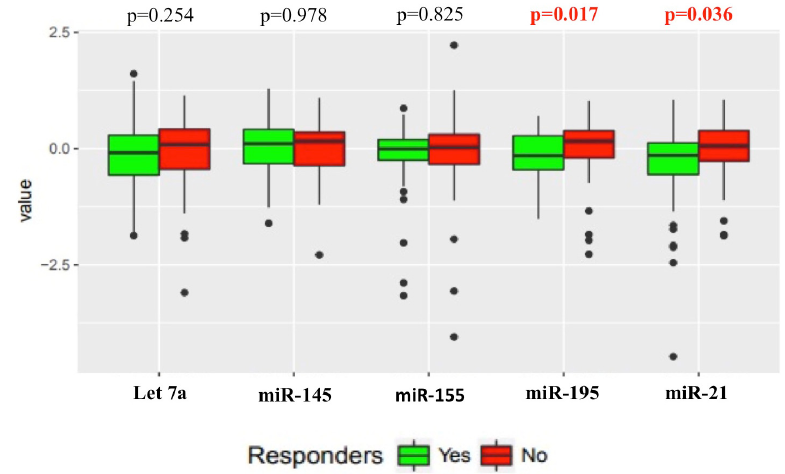
Figure 2. Relationship between the target miRNAs levels and tumour bed response to NACT in responders compared to non-responders. Responders n = 51, Non-responders n = 58. p < 0.05 considered significant.